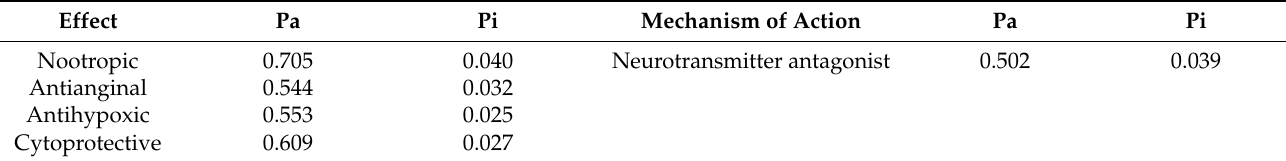
Table 1. PASS Online prediction results for compound 1 regarding nootropic and cerebral anti-ischemic effects.